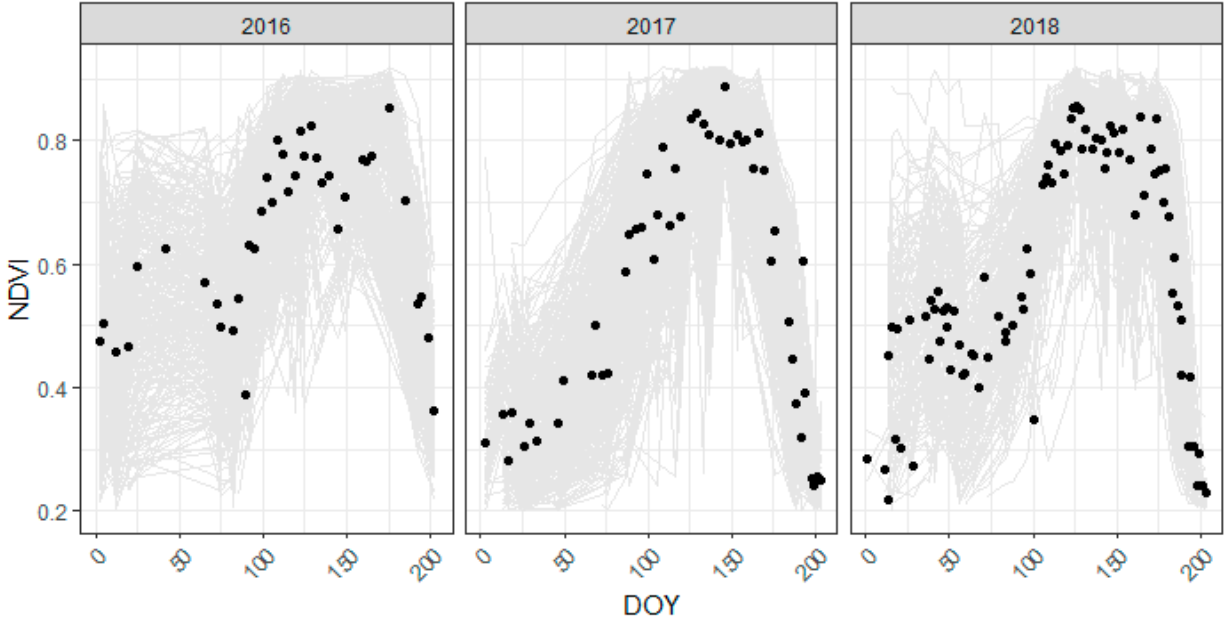
Figure 3. NDVI series used for the calculation of aNDVI and maxNDVI for the years 2016 to 2018 for each field (light grey). The black points represent the average NDVI profile of all fields in a particular year. DOY: day of year.